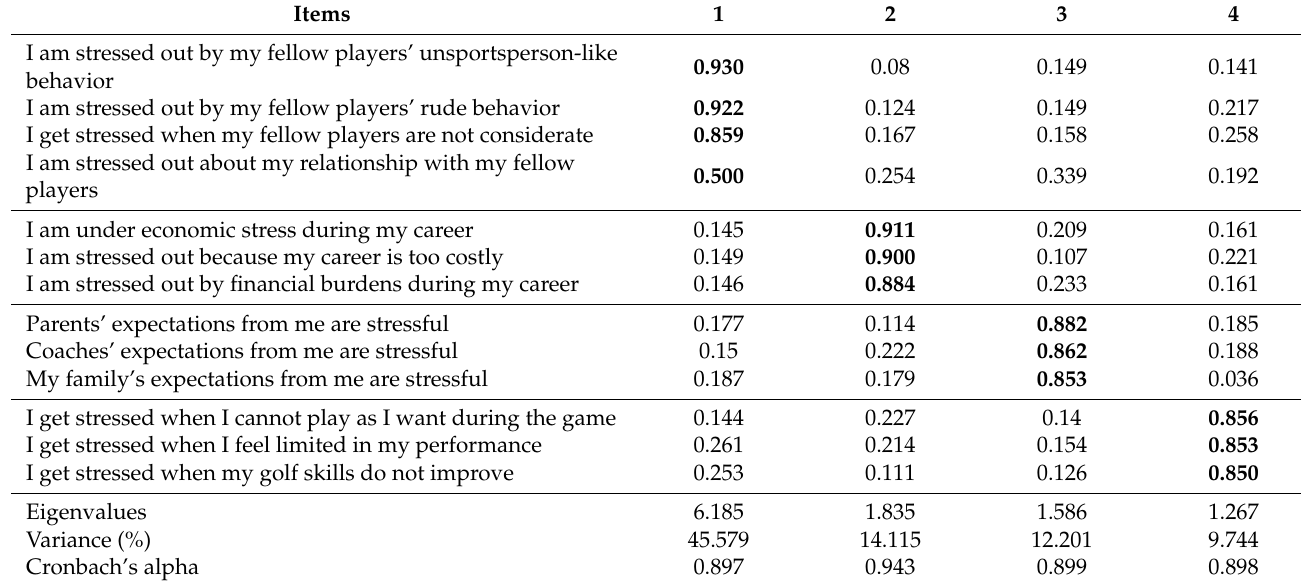
Table 2. Factor matrix structure for stress.